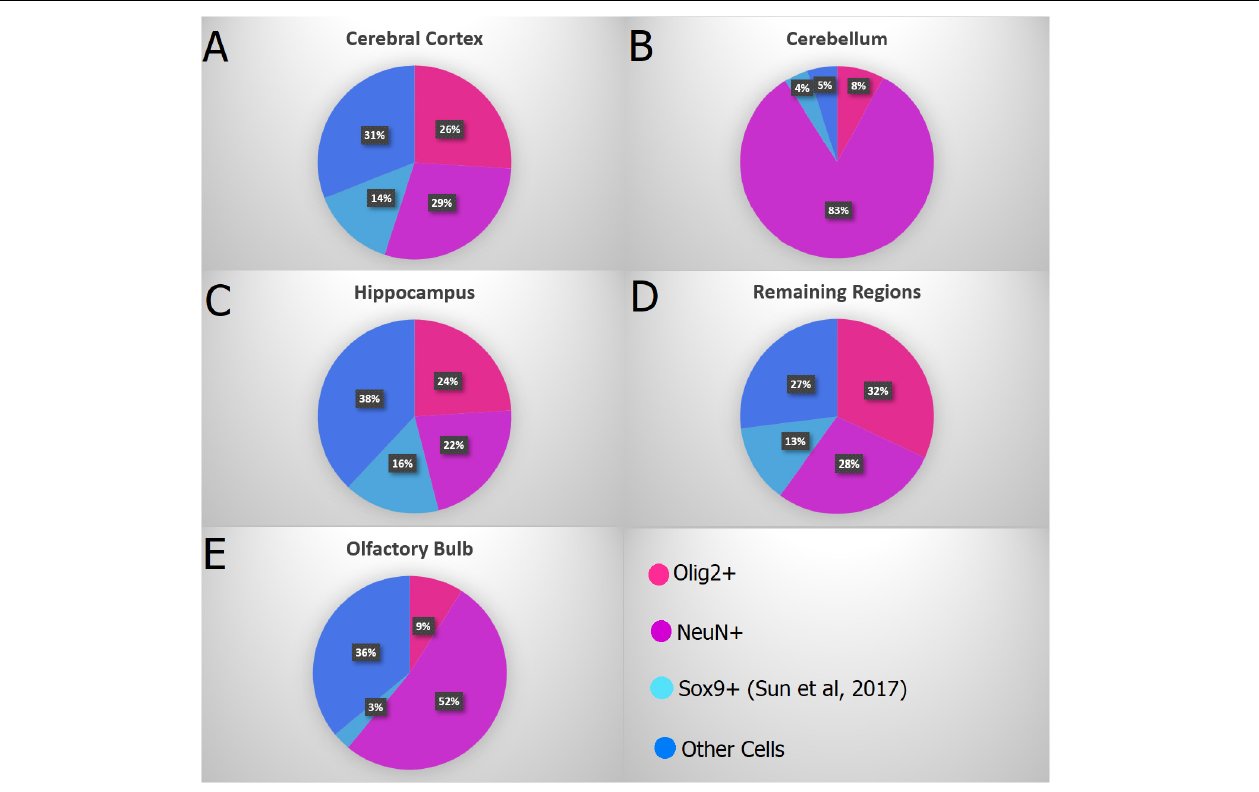
FIGURE 10 | Combined data showing the proportion of Olig2+ nuclei in pink (oligodendrocytes), NeuN+ nuclei in purple (neurons), Sox9+ nuclei in light blue (astrocytes – Sun et al., 2017) and the remaining cells in dark blue in the main regions: (A) Cerebral cortex ( anterior neocortex plus remaining cortex ), (B) Cerebellum , (C) Hippocampus , (D) Remaining Regions ( Diencephalon + Basal Ganglia + Brainstem ), and (E) Olfactory Bulb . Both studies (Sun et al., 2017 and ours) used adult mice brains from the C57BL/6 lineage, allowing an integrated analysis of both